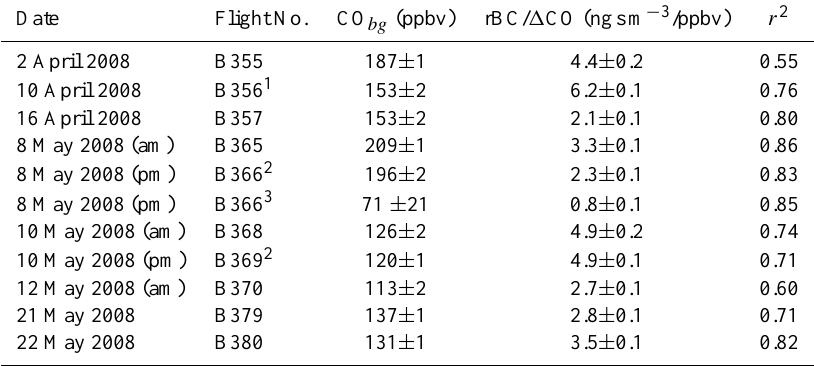
Table 2. List of flight-averaged “background” carbon monoxide (CO bg ) mixing ratios, rBC/ 1 CO ratios, and coefficient of determination for the relationship between rBC mass concentrations and 1 CO mixing ratios. Statistical uncertainties from the regressions used to obtain the CO bg values and rBC/ 1 CO ratios are also